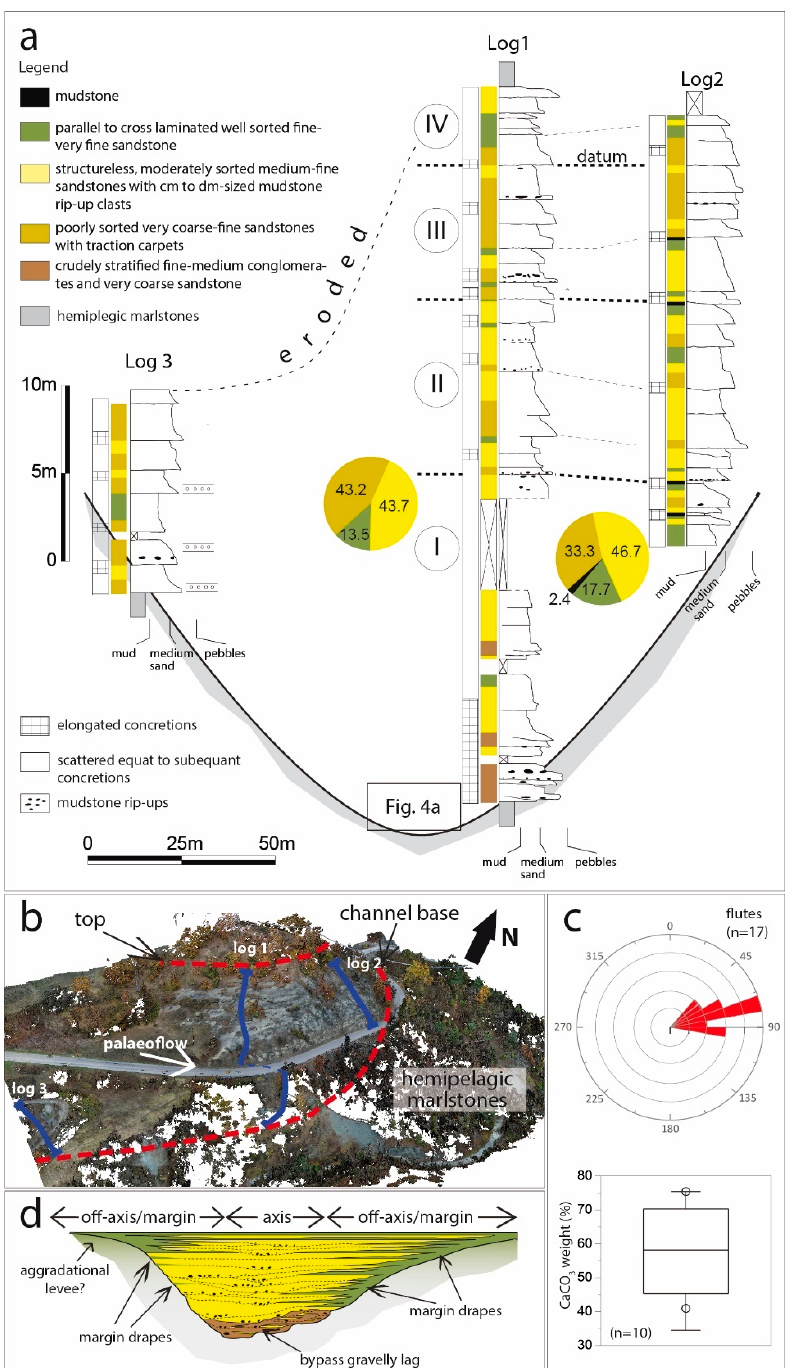
Figure 3. ( a ) Correlation of sedimentary logs with boundaries of bed sets I ‐ IV discussed in the text, facies and concretion types (left ‐ hand side of logs). Pie charts indicate facies percentages in the correlative interval of logs 1–2; ( b ) View of the photogrammetric model of the Cappella della Valle outcrop (CdV) with base and top boundaries and location of the sedimentary logs; ( c ) Rose plot of paleoflow direction from flutes casts from the CdV base and box ‐ plot of calcimetry of marlstone rip ‐ ups and hemipelagic marlstones above and below CdV (circles); ( d ) Likely depositional model for CdV (modified, after McHargue et al. [51]).